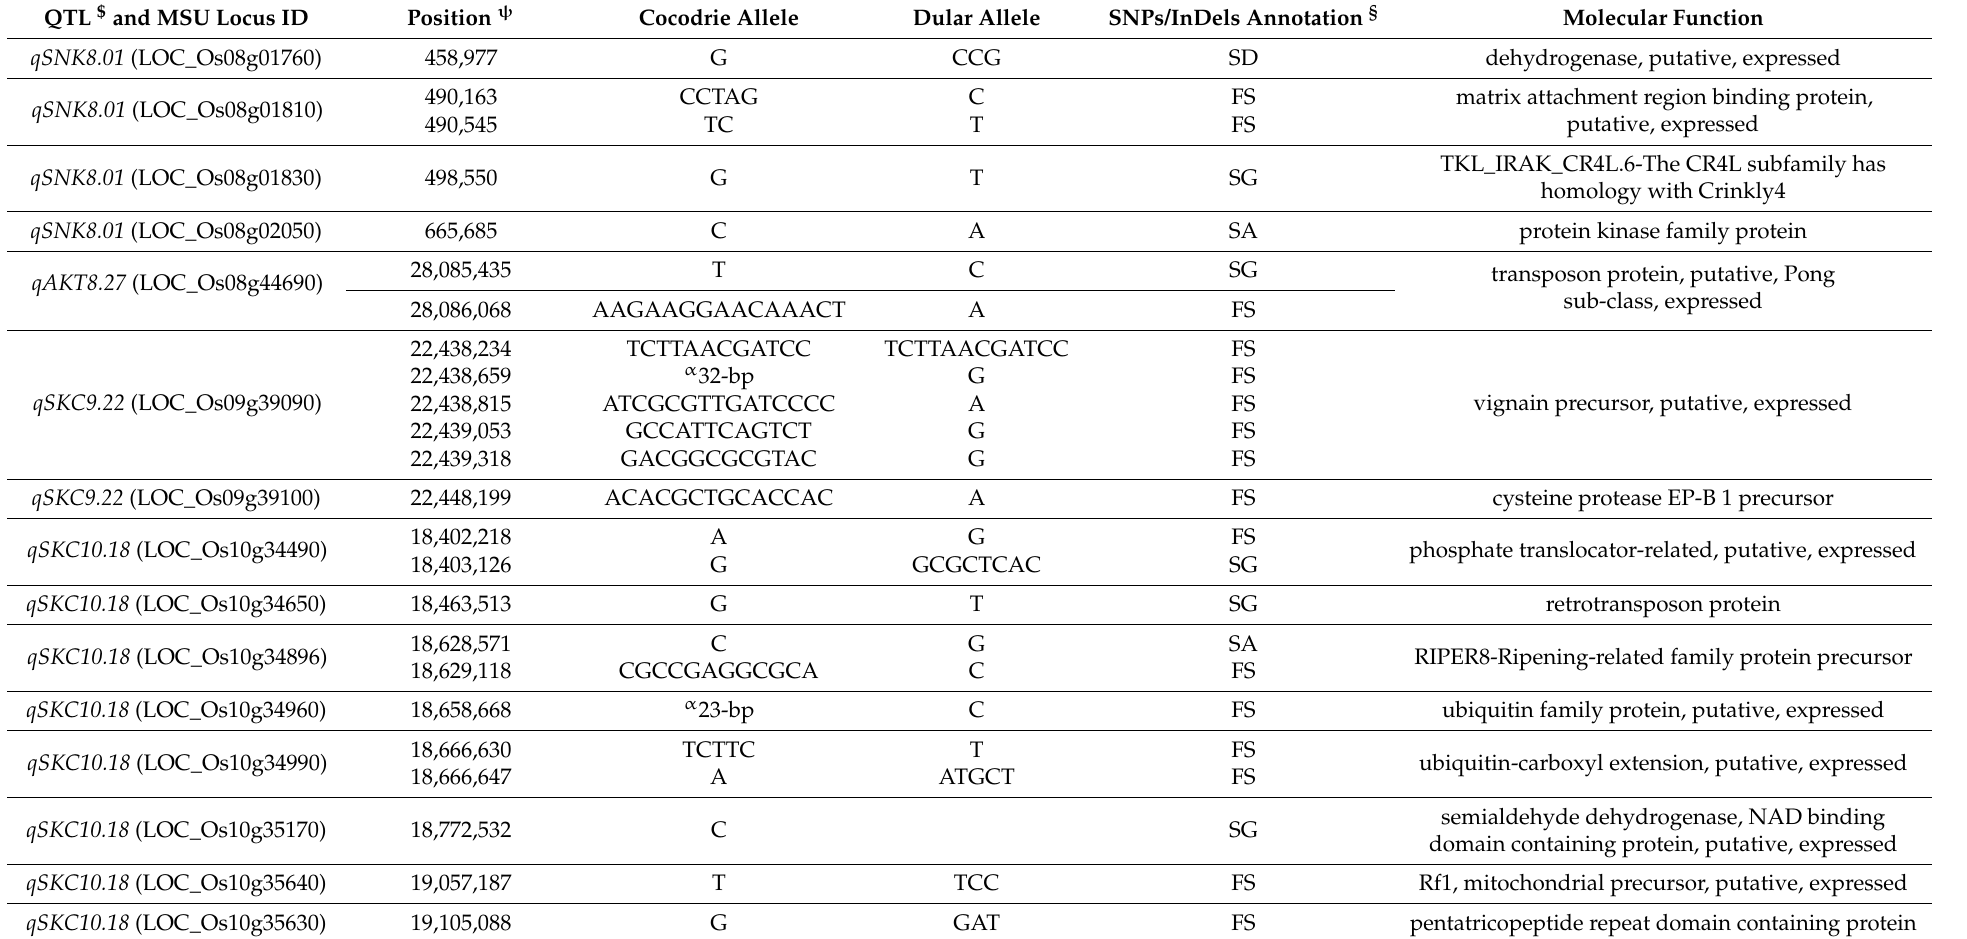
Table 7. List of polymorphic high impact SNPs and InDels in the genomic regions of selected additive